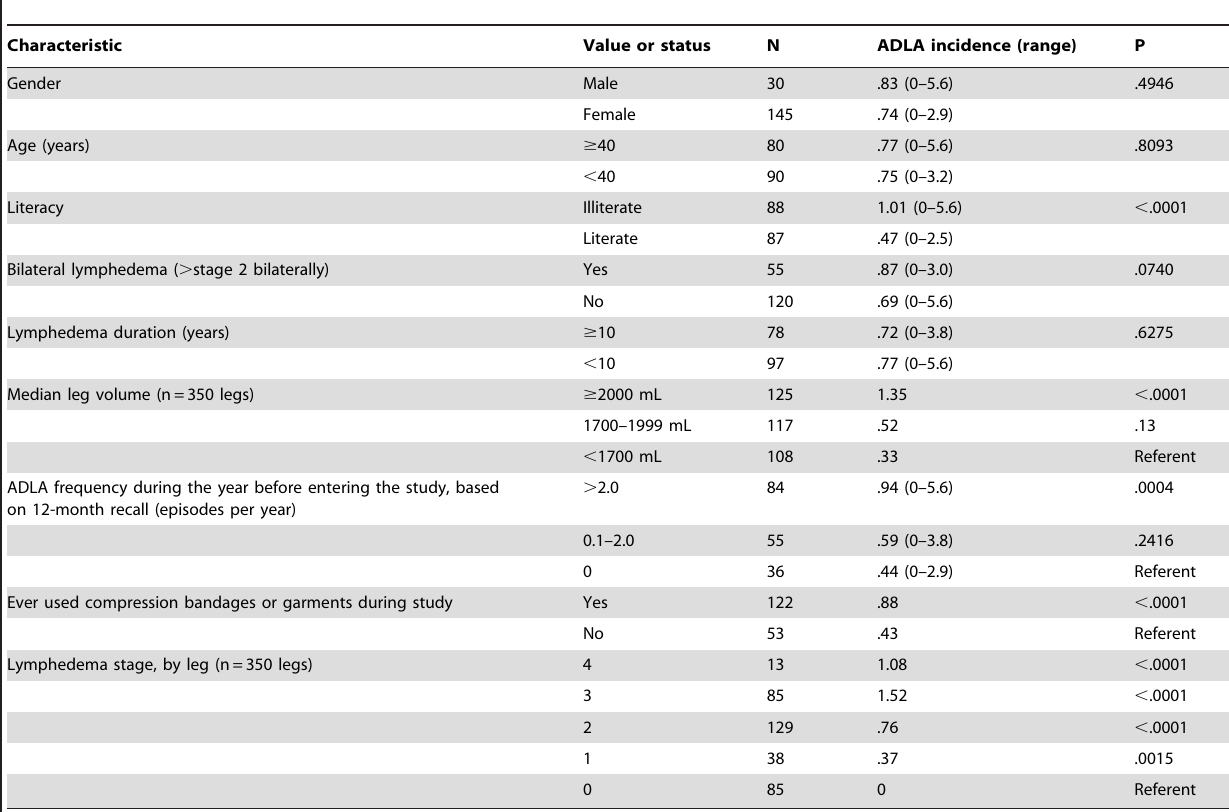
Table 2. Incidence of acute dermatolymphangioadenitis (ADLA), in episodes per person-year, among 175 patients with lymphedema in Leogane, Haiti, by demographic, disease-related, and treatment-related factors, univariate